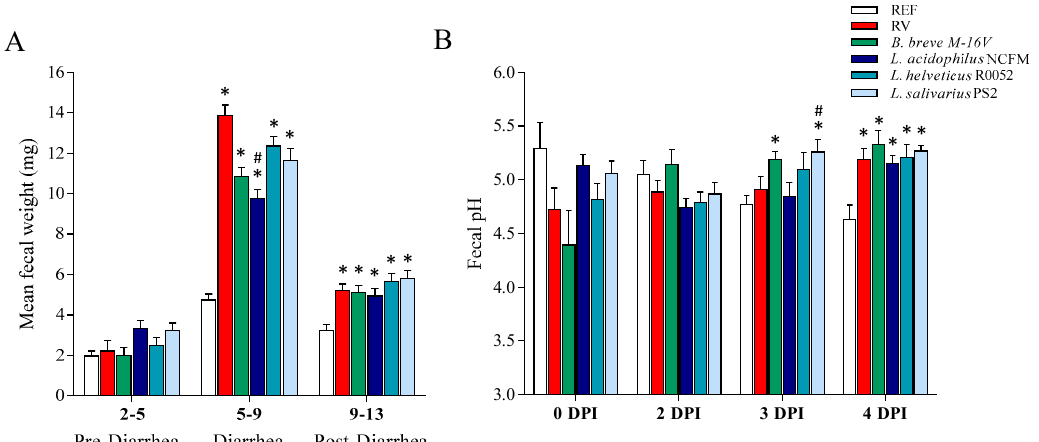
Figure 3. Fecal variables. ( A ) Mean fecal weight during the pre-diarrhea, diarrhea, and post-diarrhea periods. ( B ) Fecal pH before the infection (0 days post-inoculation, DPI) and after the infection (2, 3, and 4 DPI). Results are expressed as mean ± S.E.M. ( n = 4–21/group, depending on fecal sample availability). * p < 0.05 compared to the reference (REF) group; # p < 0.05 compared to the rotavirus